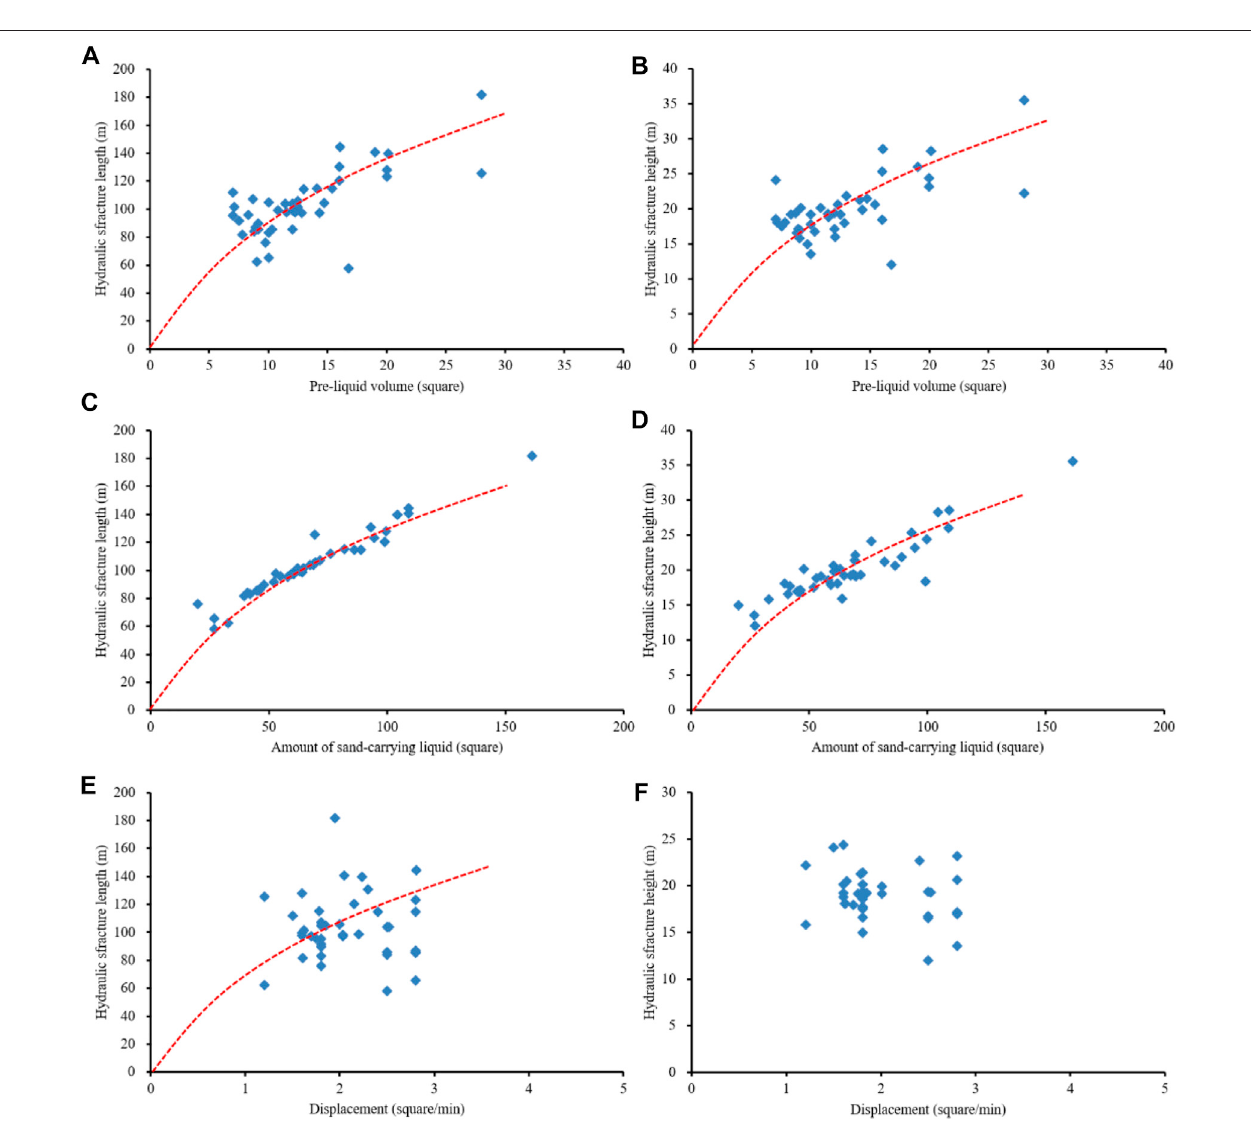
FIGURE 9 | Relationship between fracturing construction parameters and hydraulic fracture parameters. (A) Pre-liquid volume and hydraulic fracture length; (B) Pre-liquid volume and hydraulic fracture height; (C) Amount of sand-carrying liquid and hydraulic fracture length; (D) Amount of sand-carrying liquid and hydraulic fracture height; (E) Displacement and hydraulic fracture length; (F) Displacement and hydraulic fracture height.